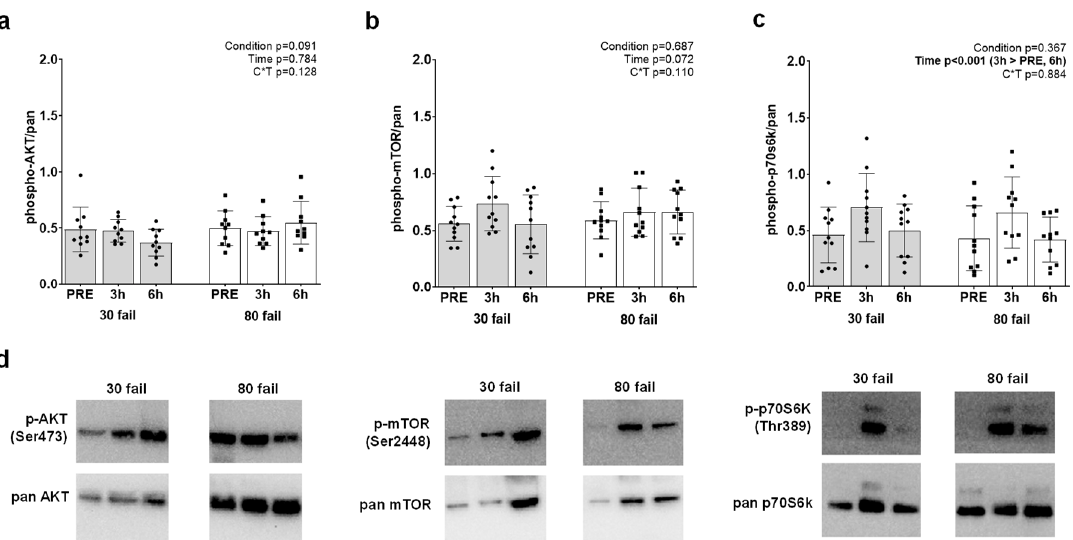
Figure 4. Phospho-signaling responses of select AKT-mTORC1 targets. Phosphorylation responses of AKT (panel a ), mTOR (panel b ), and p70S6K (panel c ), both of which are inhibitors of myostatin signaling. Notably, resistance exercise (regardless of load) increased the phosphorylation status of p70S6K. Panel d contains representative Western blots of the assayed targets. Protein abundance data for follistatin and myostatin proteins are presented in Figure 5.